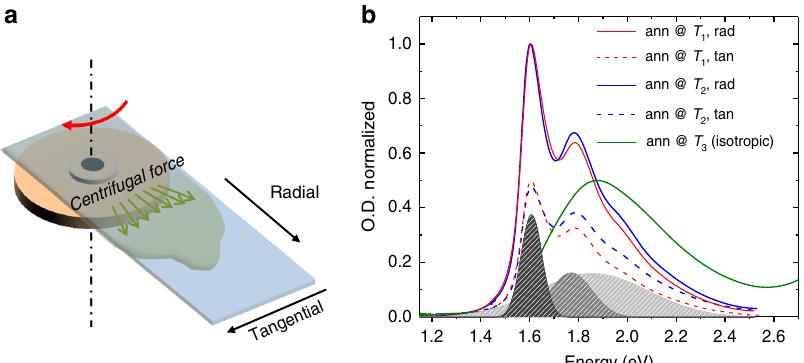
Fig. 2 Uniaxial alignment and optical anisotropy. a Schematic of the off-center spin coating deposition method; b polarized UV-Vis spectra of fi lms aligned using off-center spin coating and subsequently annealed at T 1 , T 2 , and T 3 . The grey fi lled Gaussians result from the fi tting of the spectrum of the fi lm annealed at T 1